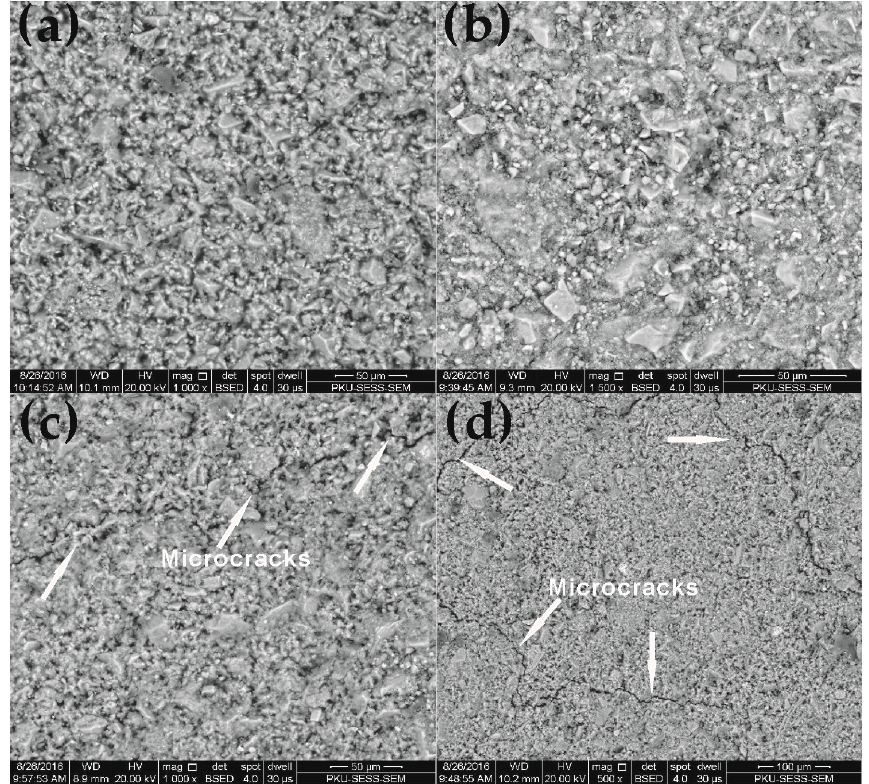
Figure 11. SEM images of 200 °C-heated specimens immersed in water for 24 h: ( a ) control, AAC with ( b ) 3% C; ( c ) 3% HPS; ( d ) 3% CMS.